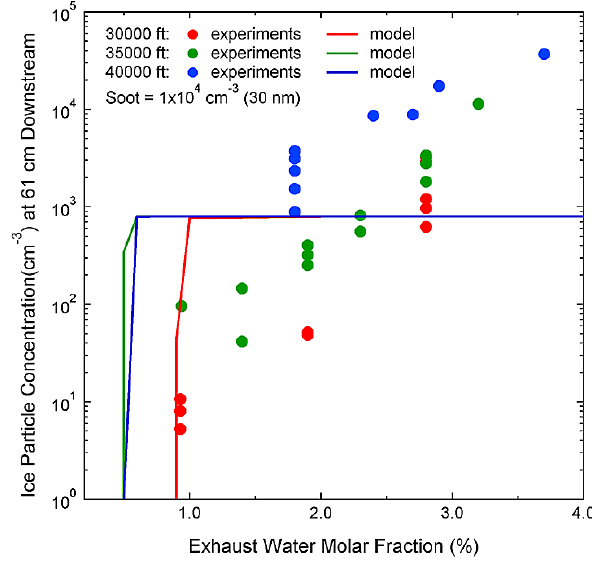
Fig. 7. Comparison of experimental and modeling results on OPC measured ice particle concentration at 61cm downstream of the nozzle under three different chamber